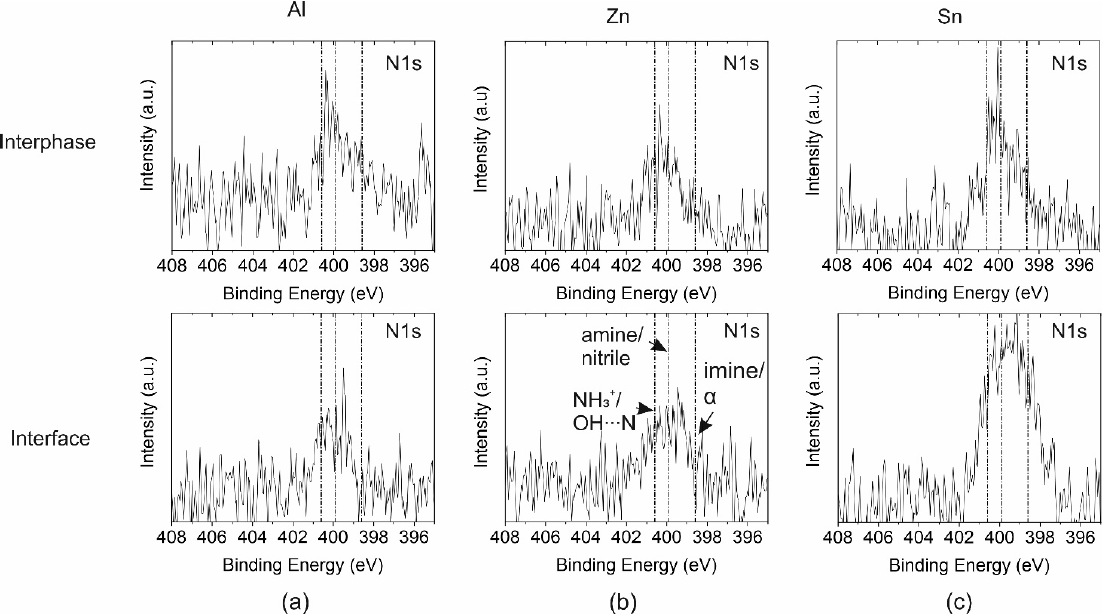
Figure 8. N1s peak in the interphase (i.e., the bulk of the epoxy coating) and at the epoxy–metal interface for ( a ) Al, ( b ) Zn, and ( c ) Sn.